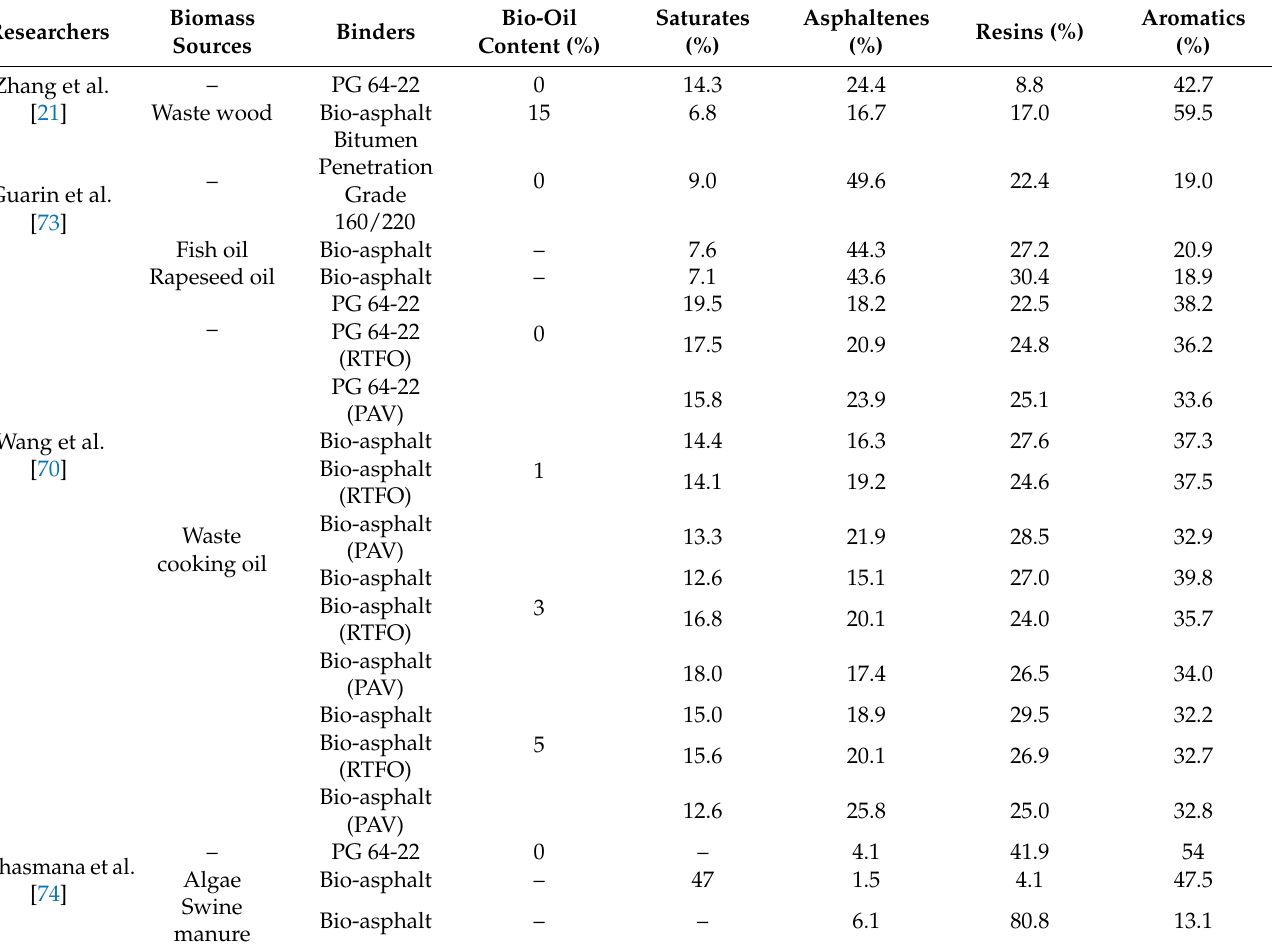
Table 9. SARA fractions of bio-oil modified